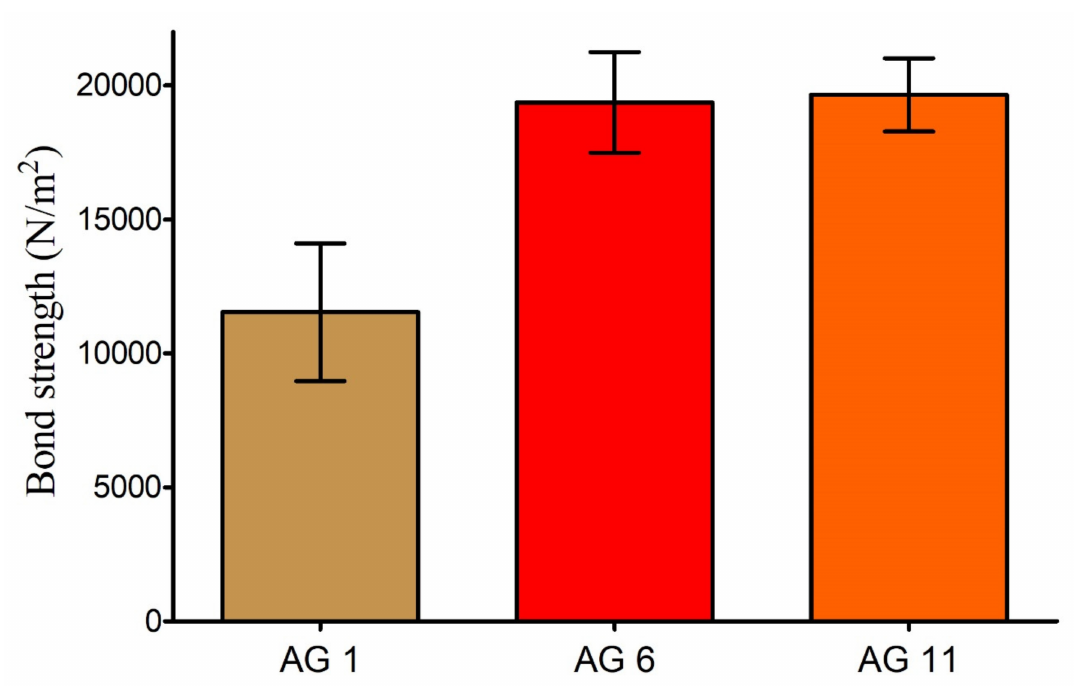
Figure 7. Mucoadhesive strength of prepared hydrogels with increasing concentration of gelatin (AG-1, AG-6, and AG-11). Error bars presents means ± SD ( n = 3).